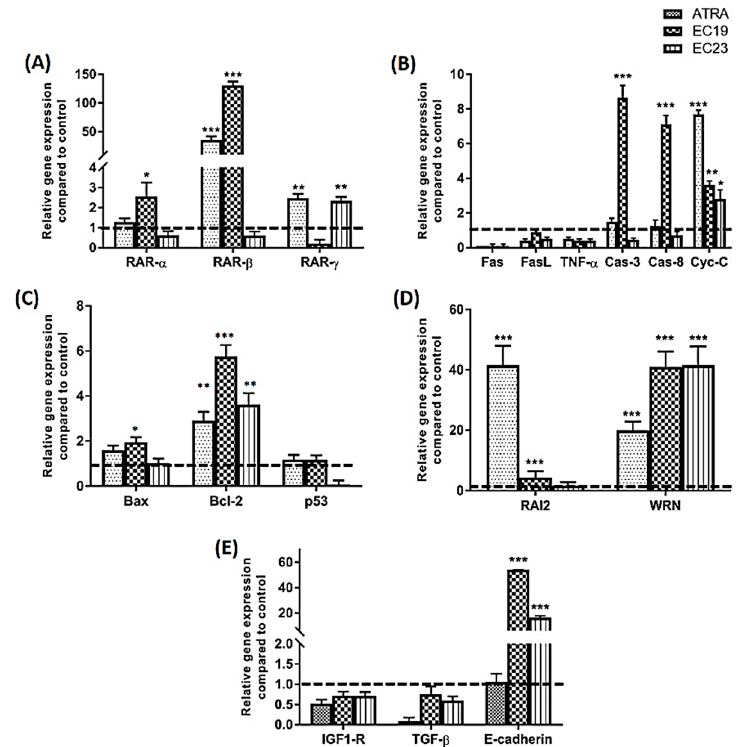
Figure 8. Gene expression analysis for different key genes after treatment of Caco-2 cells with IC 50 of retinoids for 24 h. Shown are ( A ) RARs ( α -, β - and γ -), ( B ) Key regulatory genes for extrinsic and intrinsic apoptosis, ( C ) apoptotic Bax, anti-apoptotic Bcl-2 and p53, ( D ) RAI2 and WRN genes, and ( E ) metastasis and invasion genes (IGF1-R, TGF- β and E-cadherin). The quantification of target mRNA after retinoid treatment was relative to Caco-2 cells incubated with 0.1% DMSO vehicle for 24 h and was normalized to the internal reference gene glyceraldehyde 3-phosphate dehydrogenase (GAPDH) (dashed line at 1). Relative gene expression was calculated by 2^ – ΔΔ Ct method and presented as an average of three independent experiments. The values are considered statistically significant compared to solvent-treated control at * p < 0.05, ** p < 0.01, *** p < 0.001. Data are represented as mean ± SEM, n = 3.